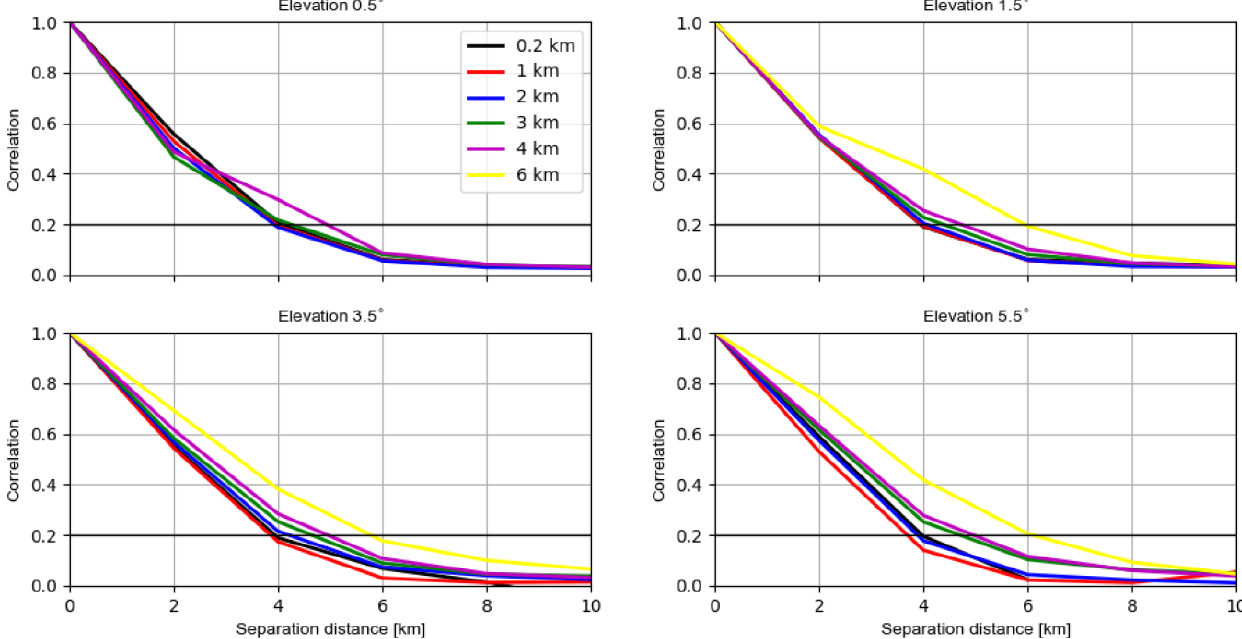
Figure 6. The estimated horizontal correlations of the RE for reflectivity data ≥ 5dBZ for elevations of 0 . 5, 1 . 5, 3 . 5 and 5 . 5 ◦ at heights of 0.2, 1.0, 2.0, 3.0, 4.0 and 6.0km. For each elevation, the samples are binned every 2km in the separation distance. It is possible for each elevation that samples are not available for some heights.